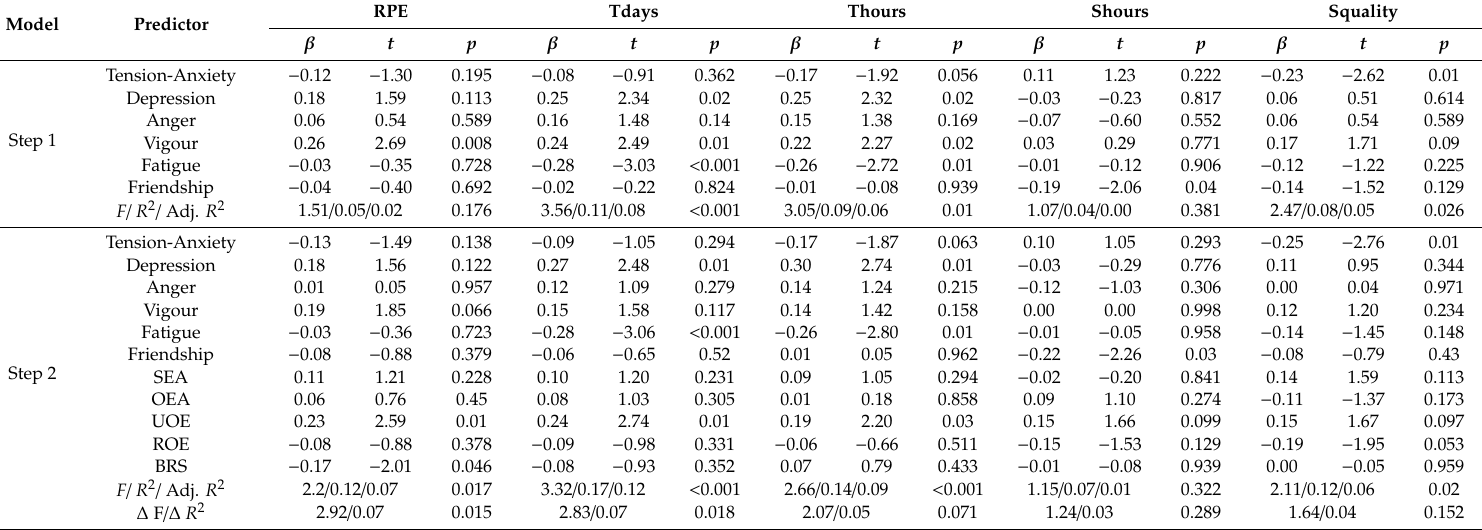
Table 4. Hierarchical regressions of training variables onto the psychological factors (moods, emotional intelligence, and resilience) of handball players.